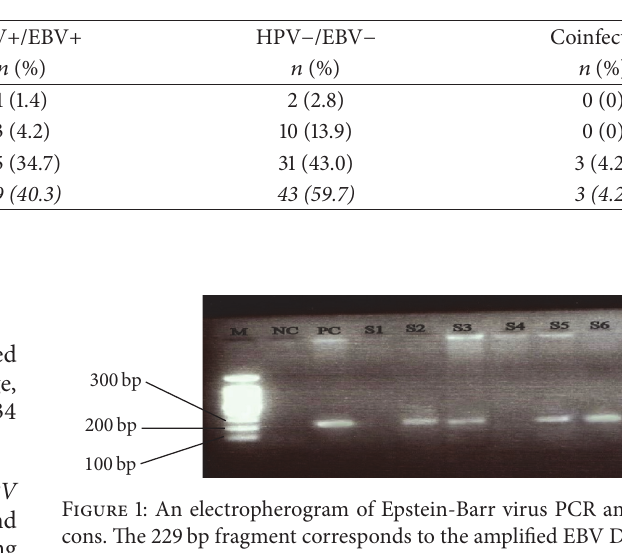
Table 2: Summary of EBV/HPV DNA in NPC cases 𝑛 = 72 .